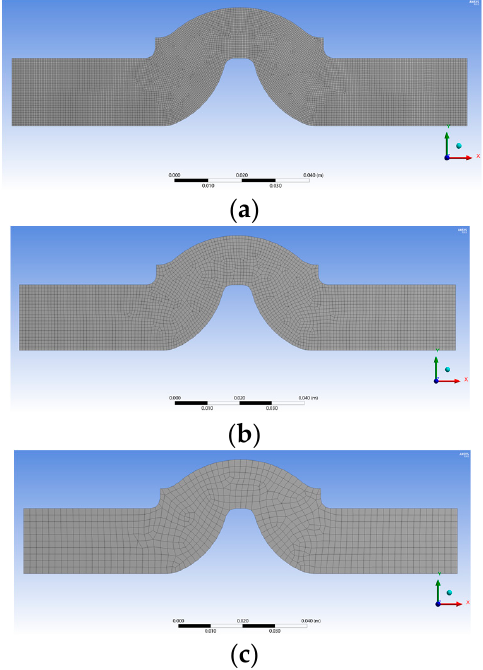
Figure 8. Mesh of different sizes under profile E. ( a ) for 0.5 mm; ( b ) for 1 mm; ( c ) for 2 mm.